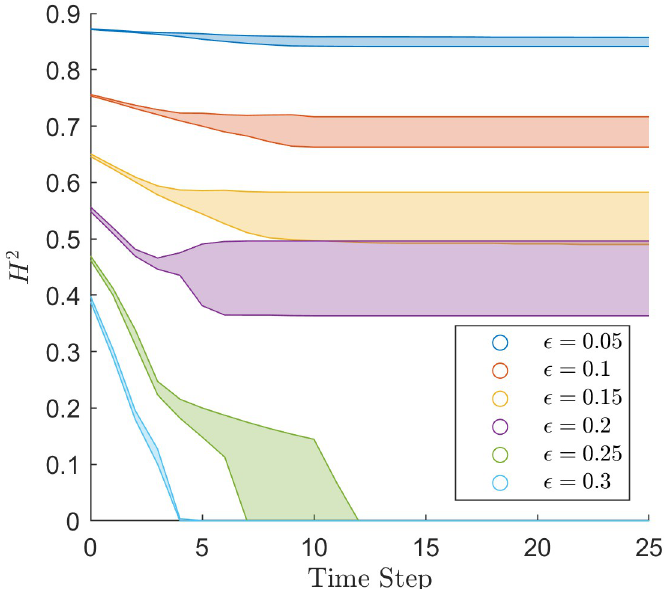
Fig 9. Mean Hellinger distance through time of the simulations that used the H-K bounded confidence model with different values of � .